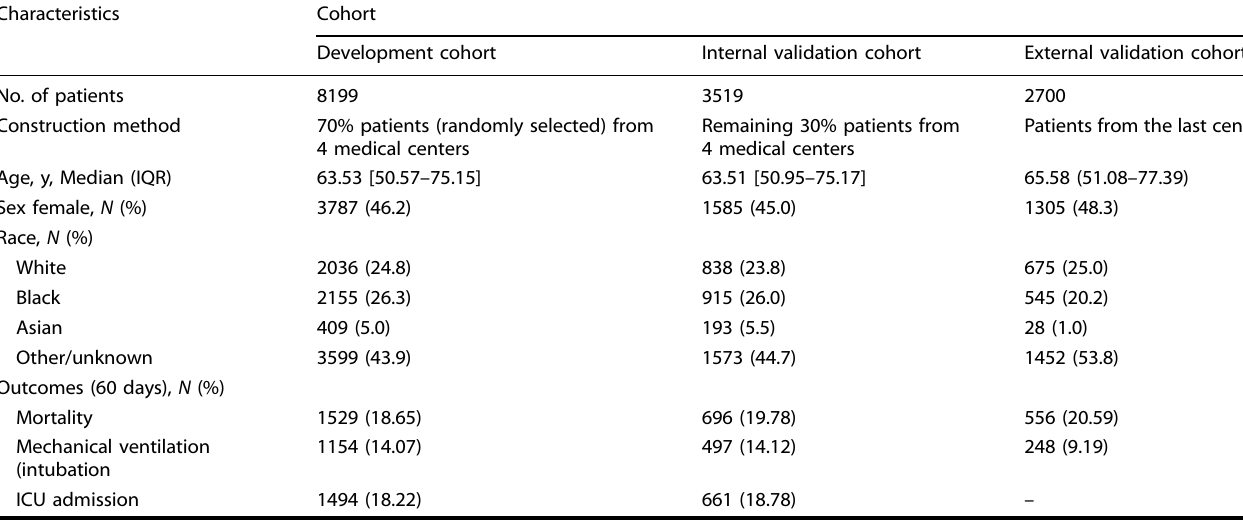
Table 1. Characteristics of the development, internal validation, and external validation